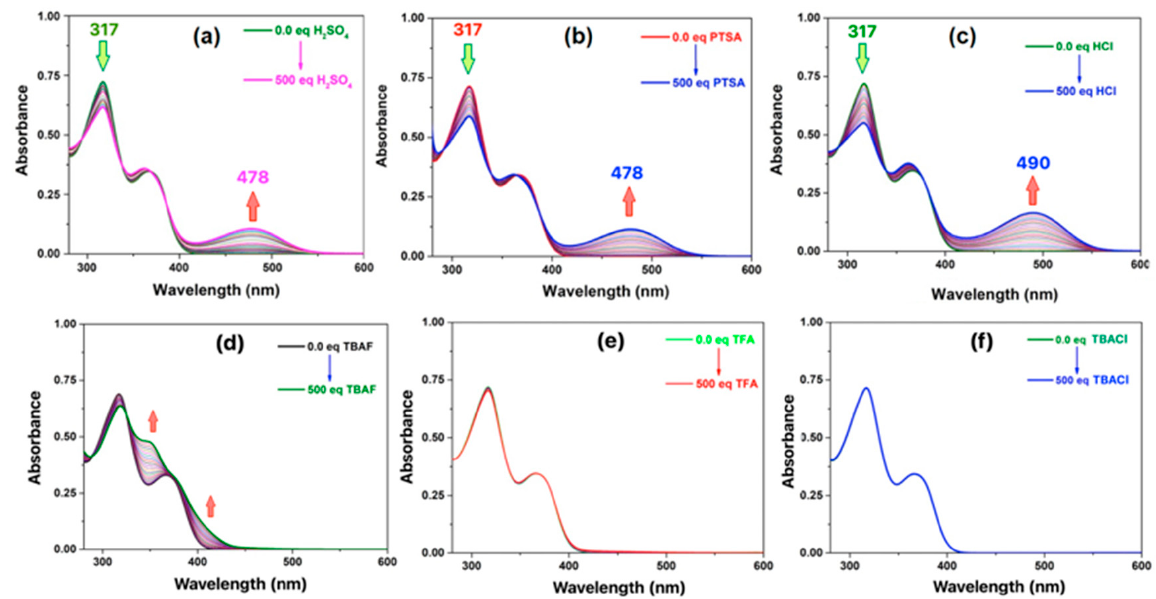
Figure 5. ( a – f ) Ultraviolet–visible (UV–vis) spectroscopic titration results showing the changes in the spectral features observed when receptor 10 was titrated against increasing quantities of (up to 500 equiv) H 2 SO 4 , PTSA, HCl, TBAF, TFA, and TBACl, respectively. All of the experiments were carried out with [10] = 2.00 × 10 − 5 M in anhydrous THF at 298 K.